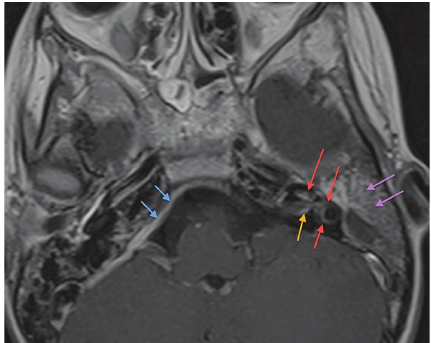
Figure 4: Axial post-Gad T1WI FSE. Thick dural enhancement is noted in the posterior fossa (blue arrows). There is enhancement in the left internal auditory canal (orange arrow). There is left mastoid sinus opacification with enhancement (purple arrows). There is enhancement of the entire right labyrinth (red arrows).